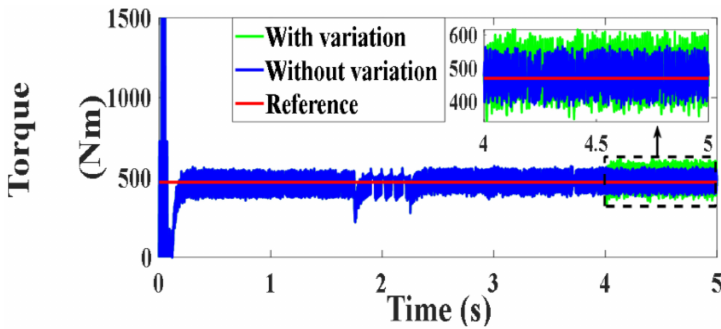
Figure 93. Developed torque under PVC (Nm).